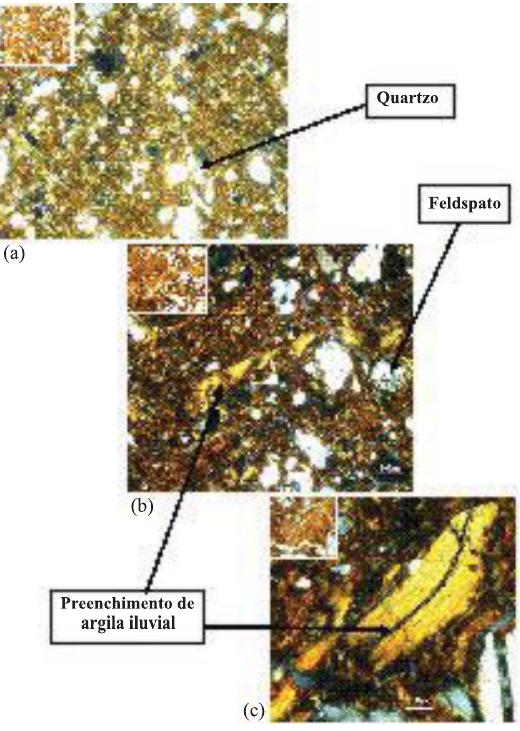
Figura 5. Fotomicrografias (XPL) do horizonte Bi1 do perfil P3, com detalhes sob luz PPL: (a) fundo matricial composto por mica incorporada ao plasma e grãos de quartzo e feldspatos potássicos; (b) preenchimento denso de argila iluvial, com orientação moderada; (c) preenchimento iluvial fragmentado (pápulas), com forte